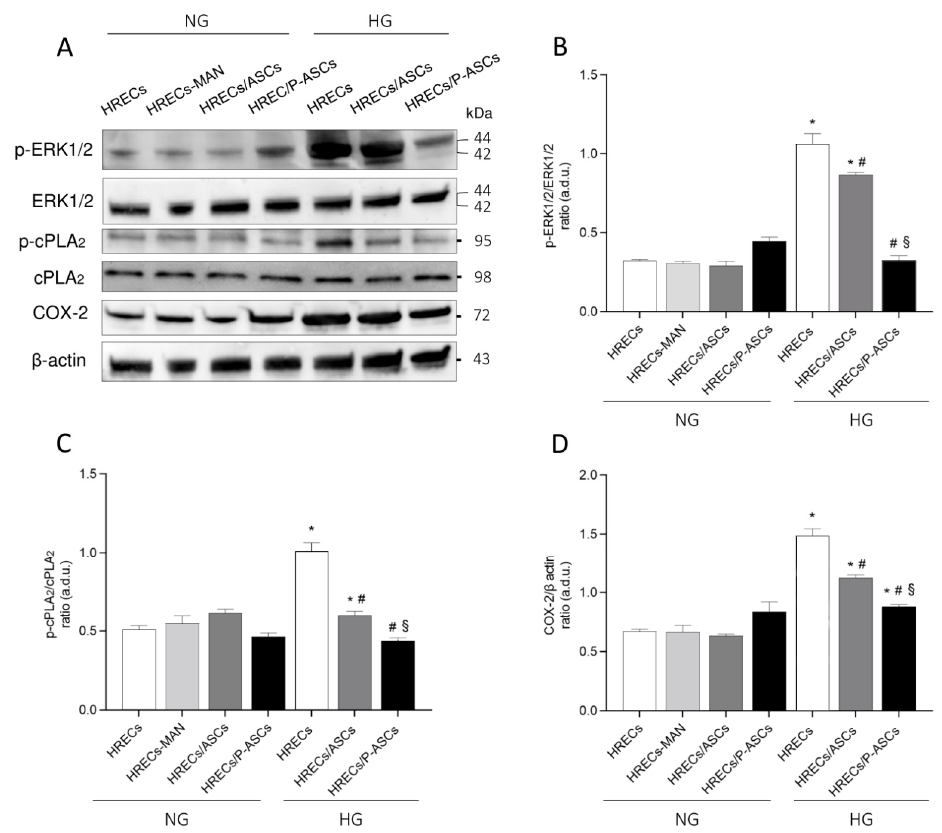
Figure 5. Evaluation of the ERK1/2 ‐ cPLA2 ‐ COX ‐ 2 axis in cultures of human retinal endothelial cells (HRECs) alone and co ‐ cultured with human adipose ‐ derived mesenchymal stem cells (ASCs) or pericyte ‐ like ASCs (P ‐ ASCs). Data were gathered by Western blot analysis from samples that were cultured either in normal glucose (NG) or high glucose (HG) conditions. Immunoblot analyses were performed in HREC populations using specific antibodies against p ‐ ERK 1/2 and total ERK 1/2, activated (phosphorylated, p ‐ cPLA2) and total cPLA2, and COX ‐ 2 proteins (panel A ). ß actin was used to verify the equal loading of 30 μ g protein per lane. Image J software was used to carry out densitometric analysis of the immunoblots, indicating protein quantification of each band (in arbitrary densitometry units, a.d.u.). Quantitative analyses of the phosphorylation rate of ERK1/2 (i.e., ratio of p ‐ ERK1/2/ERK1/2) and cPLA2 (i.e., ratio of p ‐ cPLA2/cPLA2) are indicated in panels B and C , respectively. Quantitative analysis of COX ‐ 2 protein was normalized to ß actin (panel D ). No significant differences were noted among the different samples when kept in NG conditions. In HG conditions, HREC activation of the ERK1/2 ‐ cPLA2 ‐ COX ‐ 2 axis was attenuated by the presence of ASCs and, especially, P ‐ ASCs. Each value represents mean ± SEM obtained from three independent experiments. * p < 0.05 vs. HRECs in NG; # p < 0.05 vs. HRECs in HG; $ p < 0.05 HRECs/P ‐ ASCs in HG vs. HRECs/ASCs in HG.